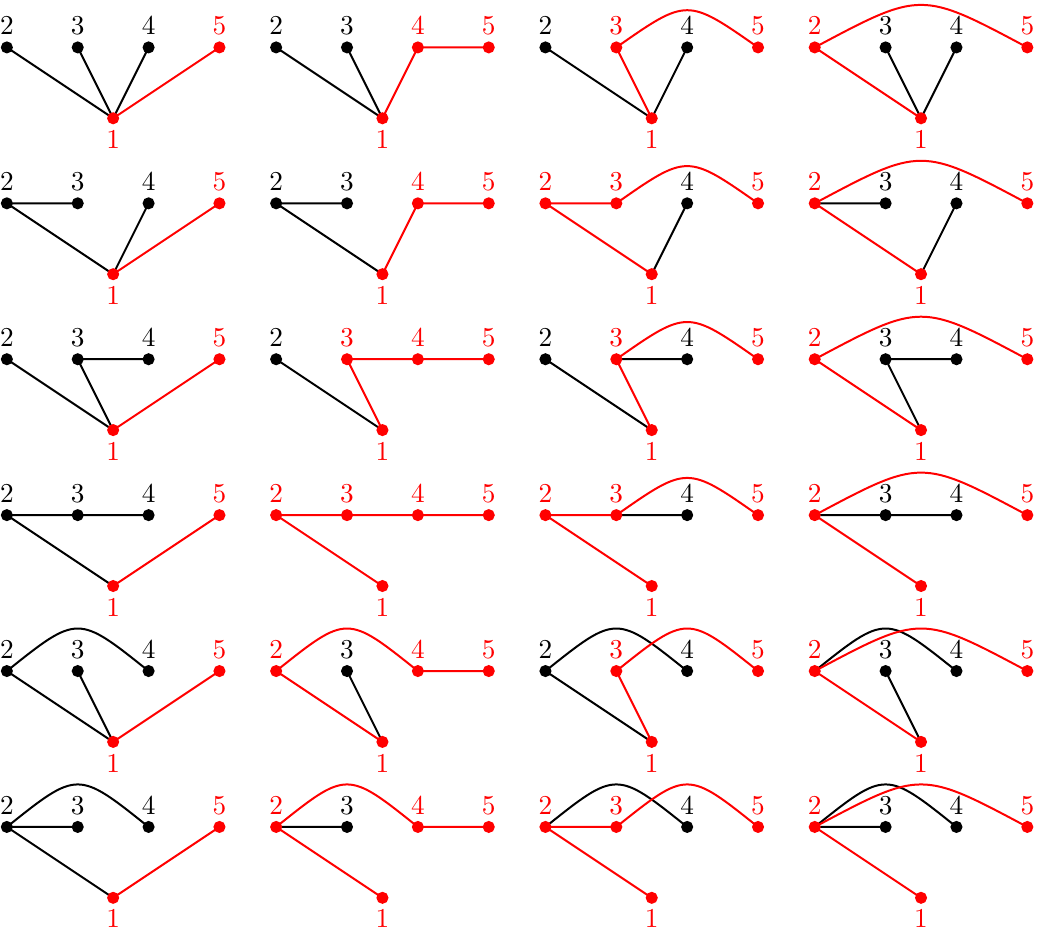
Figure 2 . The spanning trees corresponding to n (1 , { 234 } , 5) for YM. All gluon vertices are highlighted in